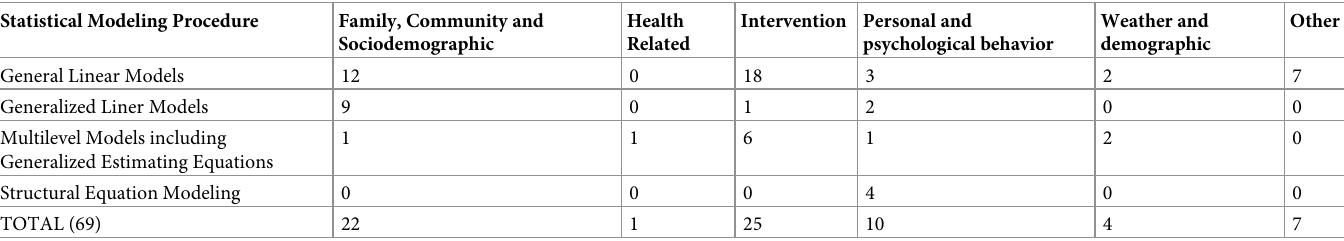
Table 1. Statistical models used in analysing step count data in relation to the scope of the article: Effect ON step counts. Statistical Modeling Procedure General Linear Models Generalized Liner Models Multilevel Models including Generalized Estimating Equations Structural Equation